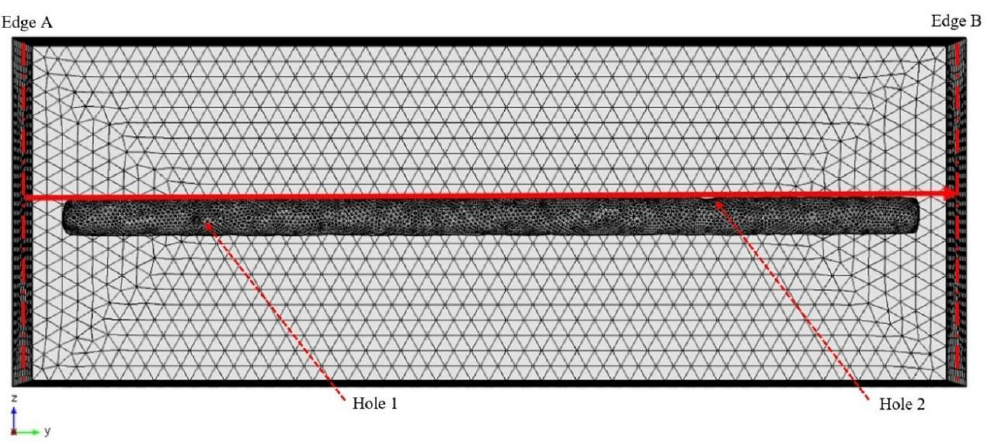
Figure 5. Path of the data recording (at the surface of the rebar in the Y direction).